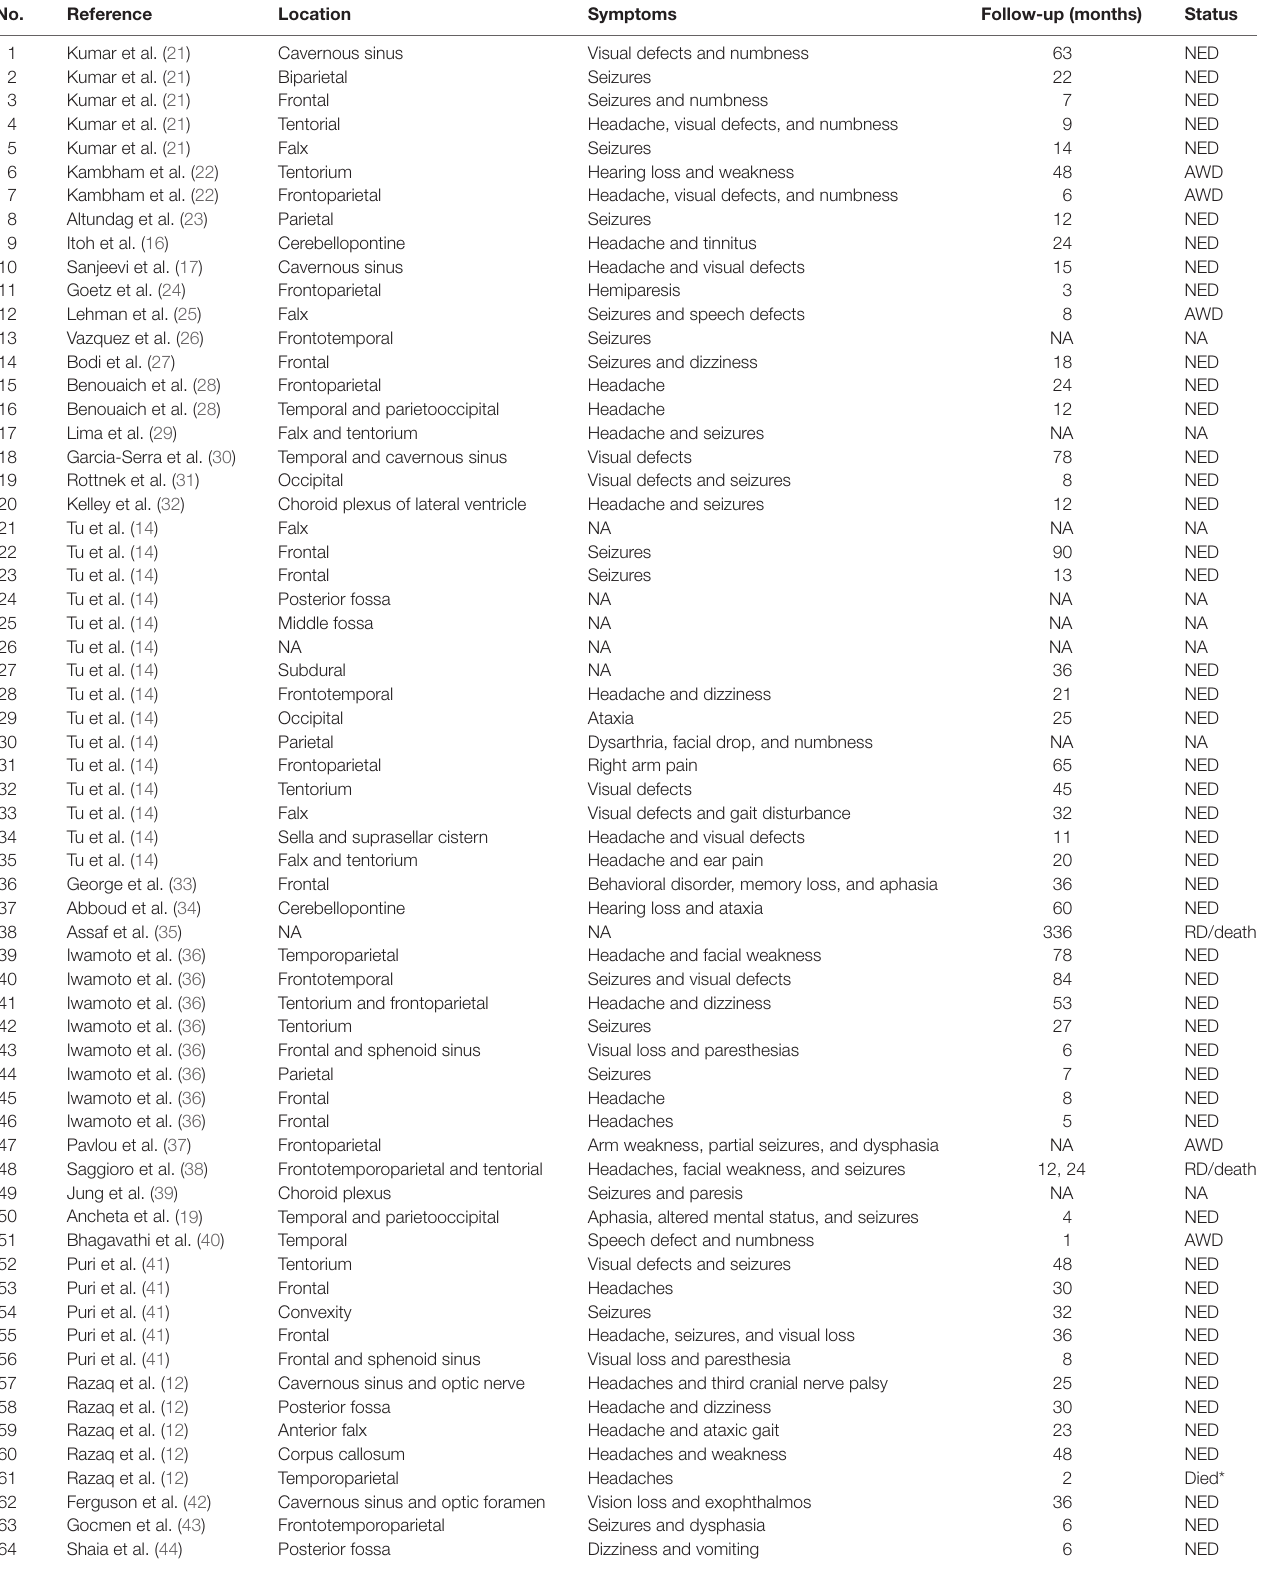
TABLe 1 | Summary of cases with central nervous system dural marginal zone lymphoma in chronological